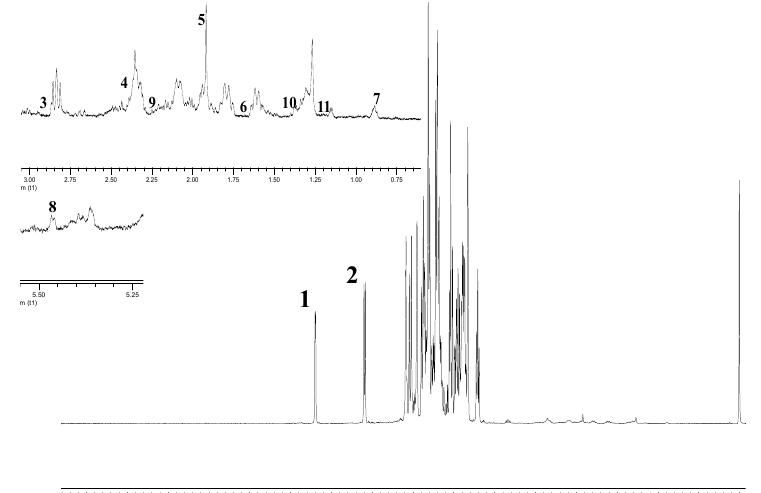
Figure 1. The representative 1 H-NMR spectra of Grade 1 Ajwa from al-Aliah farm. Identified signals